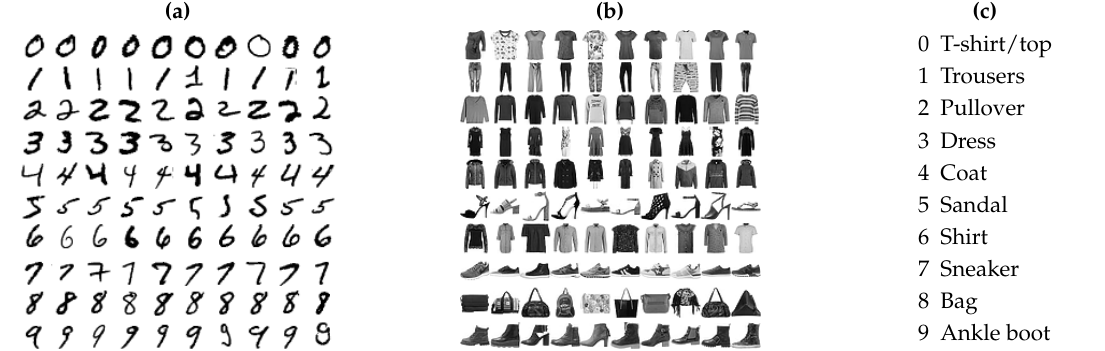
Figure 1. ( a ) Samples of the MNIST data set. ( b ) Samples of the fashion MNIST data set. Each row represents a different item type. ( c ) Corresponding labels for the fashion MNIST data